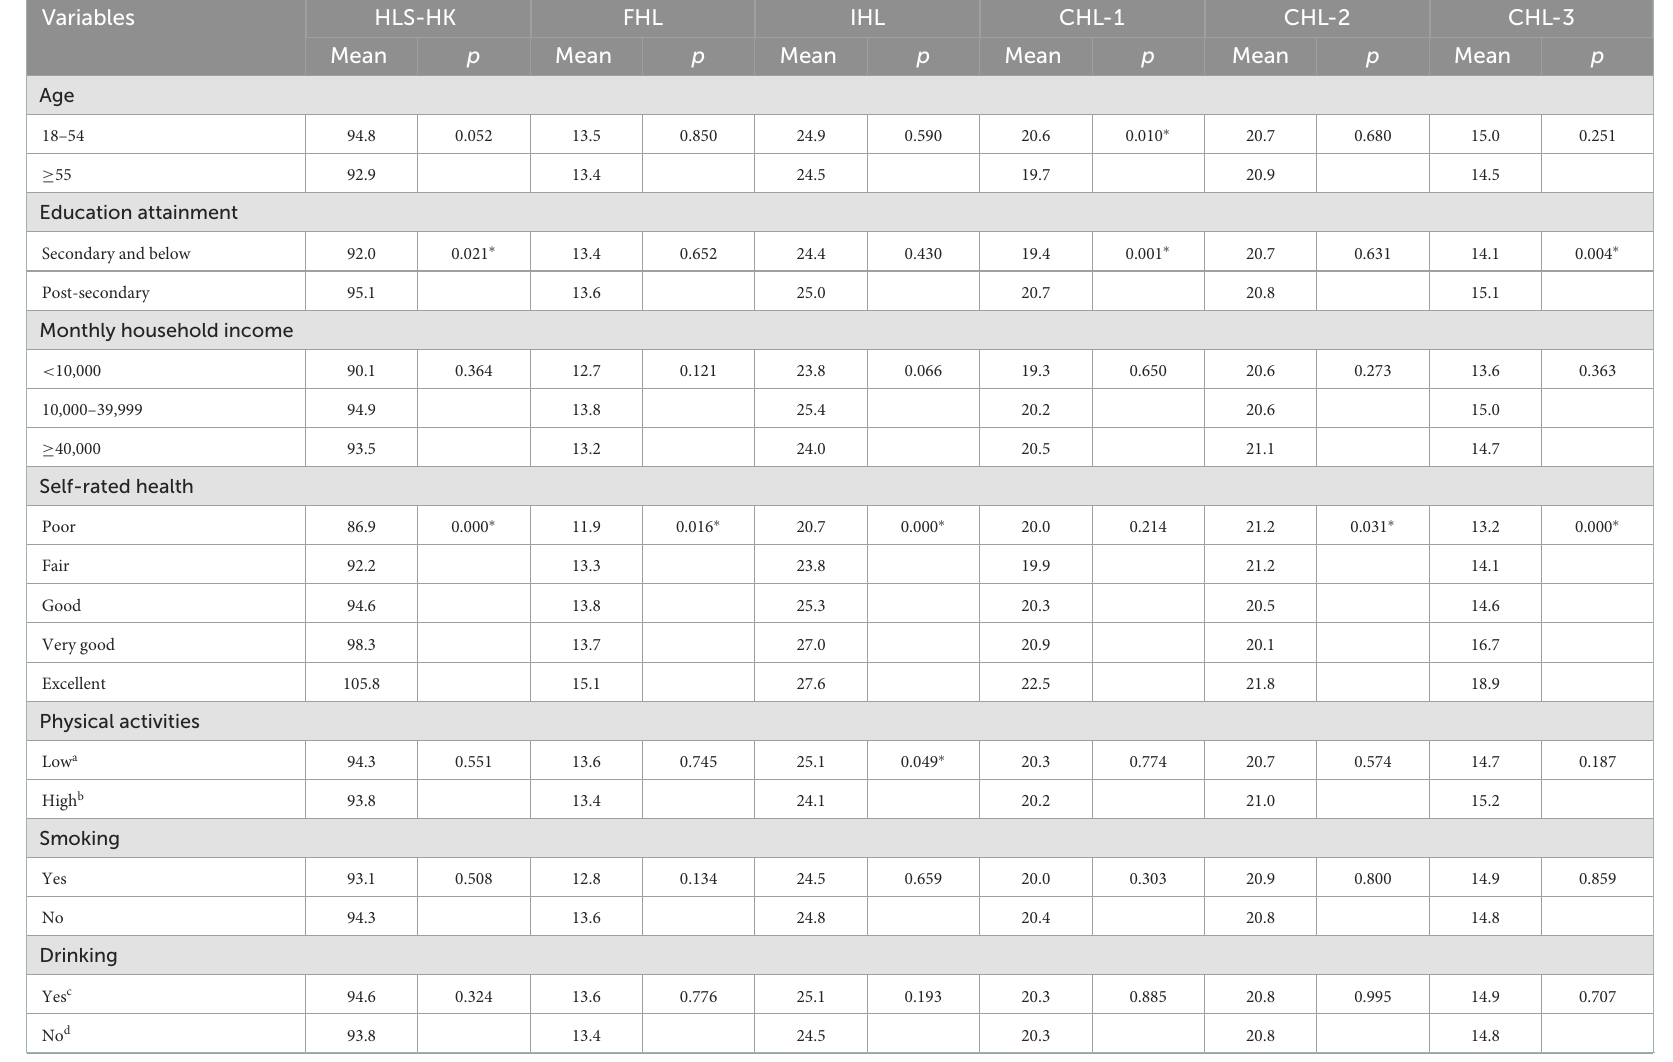
TABLE 7 Bivariate relationships of HLS-HK scores and other